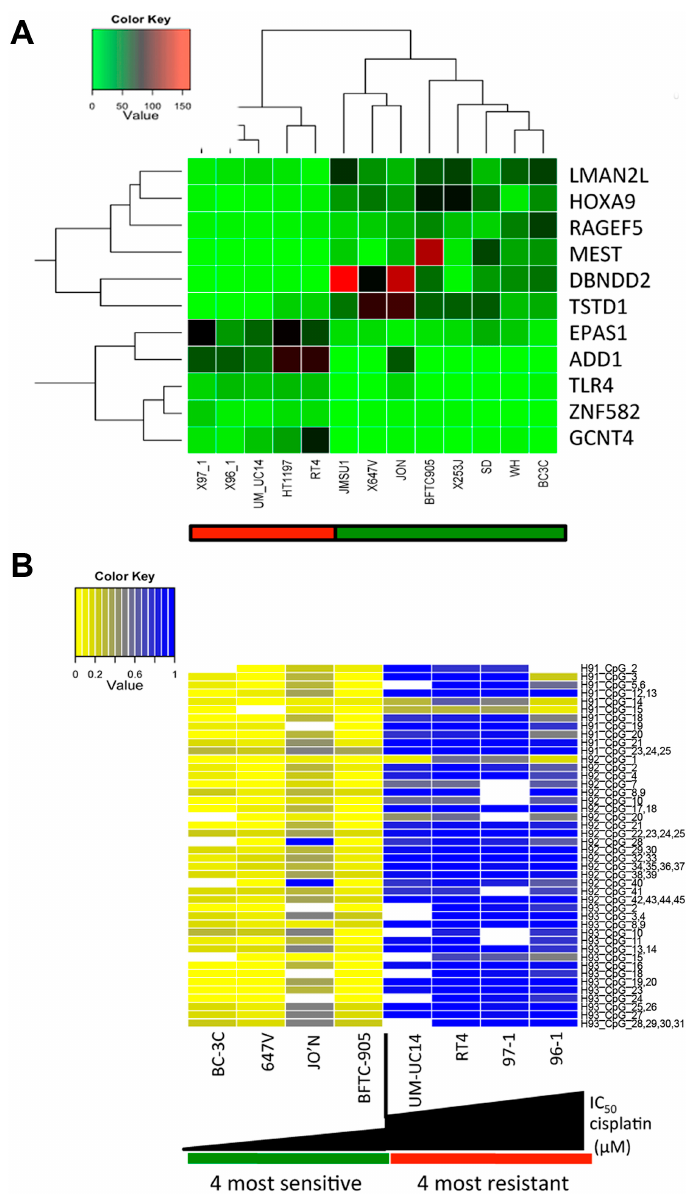
Figure 2. HOXA9 promoter methylation as marker for sensitivity and resistance in bladder cancer cell lines. ( A ) Expression profiling and hierarchical clustering of top sensitive and top resistant bladder cancer cell lines identifies candidate genes to explain sensitivity and resistance to chemotherapy. The LIMMA package (version 3.28.20) was used for analyzing differential expression of RNA sequencing (RNAseq) data between sensitive and resistant cell lines; ( B ) The HOXA9 promoter is methylated in resistant cell lines ( p < 0.001). Methylation quantification of the HOX9A promoter was carried out using the EpiTYPER assay.